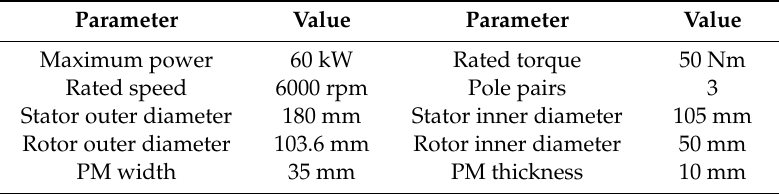
Table 1. Parameters of finite element analysis permanent magnet synchronous motors (FEA PMSM) model.